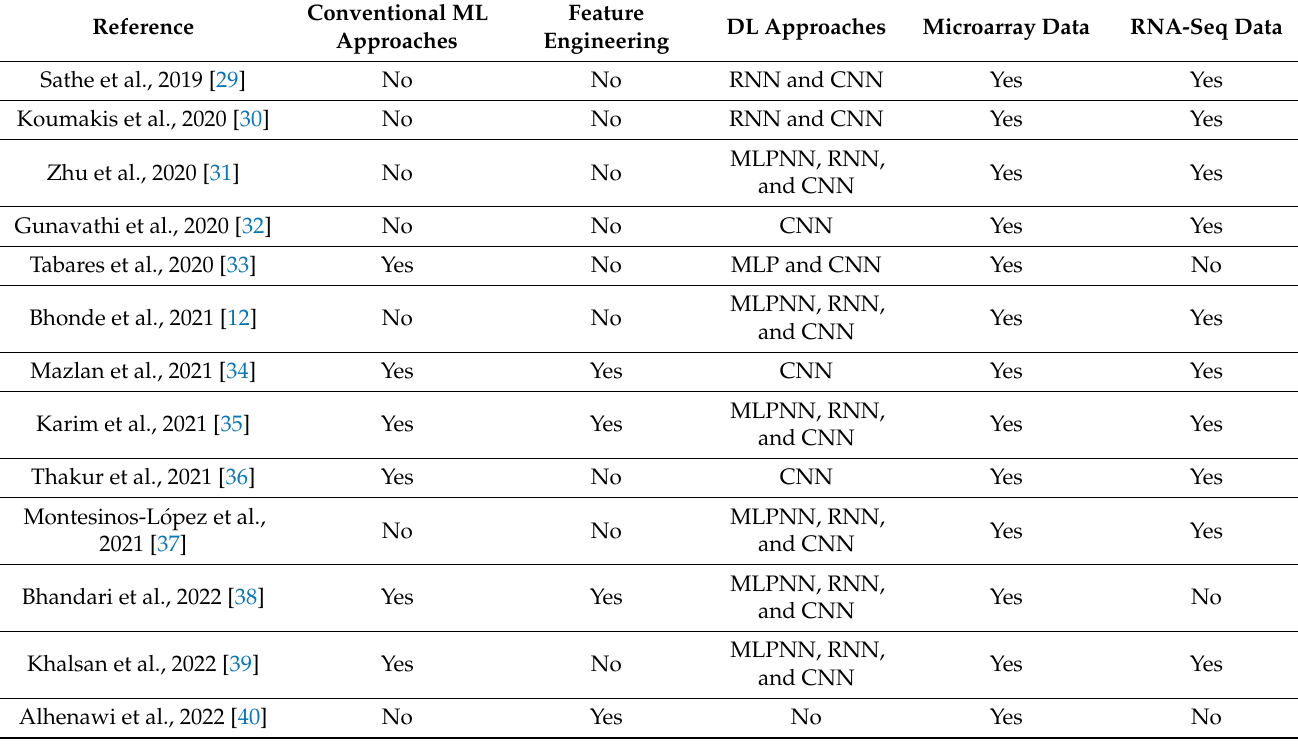
Table 1. List of previous review papers for gene expression